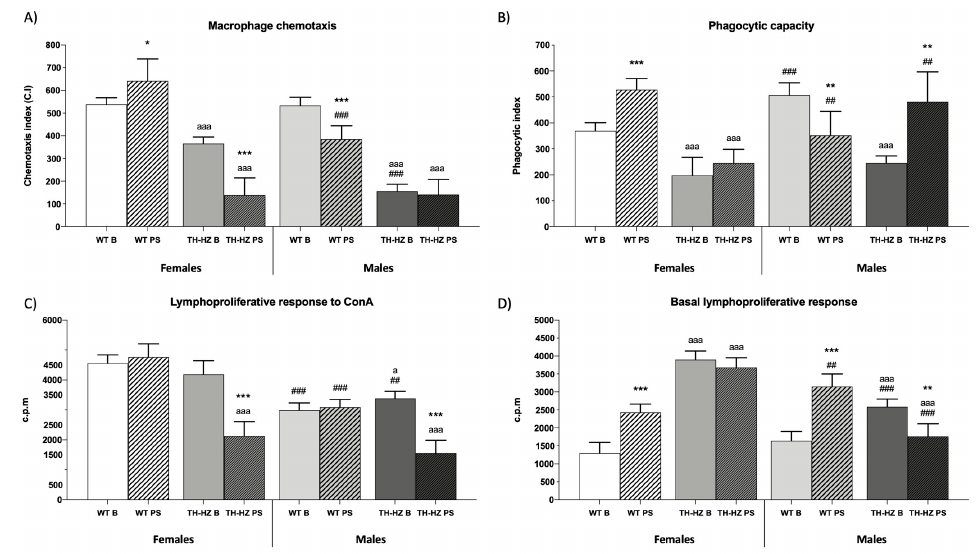
Figure 4. Immune function parameters. ( A ) Macrophage chemotaxis index. ( B ) Phagocytic index. ( C ) Lymphoproliferative response to ConA (c.p.m). ( D ) Basal lymphoproliferative response (c.p.m). Each column represents the mean ± standard deviation of values corresponding to 6 animals. * p < 0.05, ** p < 0.01, *** p < 0.001 compared to basal condition, a p < 0.05, aaa p < 0.001 compared to WT. ## p < 0.01, ### p < 0.001 compared to female. WT B: Wild type basal. WT PS: Wild type post-stress. TH-HZ B: TH-HZ basal. TH-HZ PS: TH-HZ post-stress. Table 3. Immune functions evaluated in peritoneal leukocytes of female and male WT and TH-HZ mice in basal and post-stress conditions.